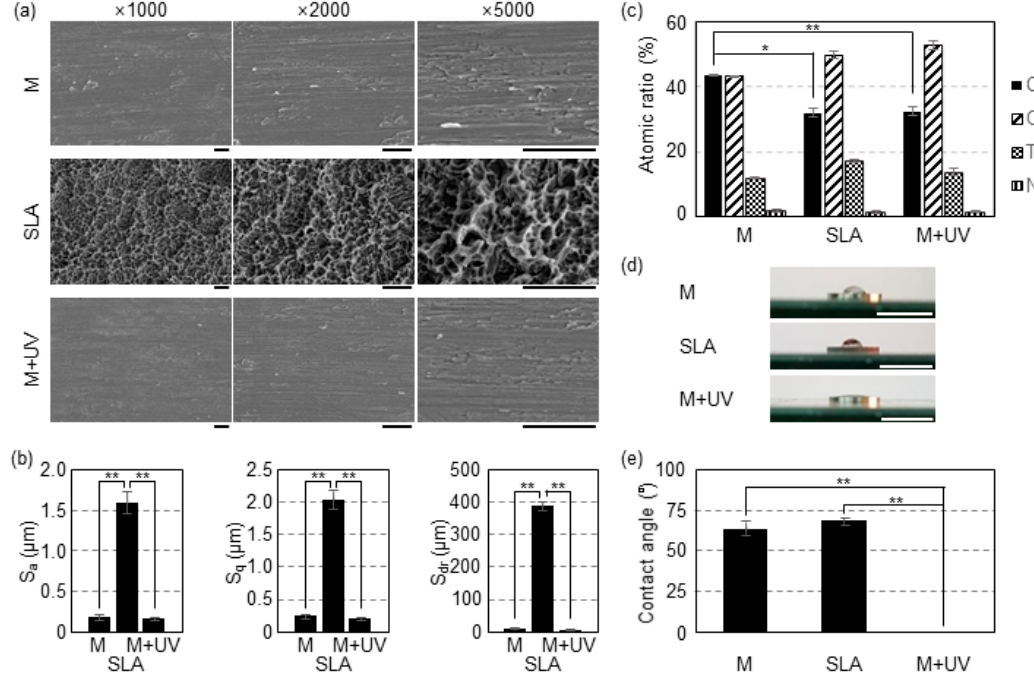
Figure 2. ( a ) Scanning electron microscopy (SEM) images of the Ti discs. M: Machined surface (top row); SLA: Sandblasted with large grit and acid etched surface (middle row); M + UV: machined surface treated with ultraviolet light (bottom row). Scale bars: 10 μ m. ( b ) Surface roughness (Sa and Sq) and surface area ratio (Sdr) of the Ti discs evaluated by confocal laser scanning microscopy (CLSM) analysis. The values for the M and M + UV surfaces are similar and smaller than the SLA. ( c ) Element content of the surfaces of the Ti disc according to the energy dispersive x-ray spectrometer (XPS). M + UV shows a significantly lower carbon percentage than the M disc, but there is no significant difference between the SLA and M + UV. ( d ) The changes in wettability of the Ti discs. Superhydrophilicity after UV treatment for 48 h was observed. Scale bars: 10 mm. ( e ) The value of the contact angle of the Ti discs. Without UV treatment, the Ti disc was hydrophobic, but became superhydrophilic (zero degree angle) after UV treatment for 48 h. Error bars show the standard deviation. (*) and (**) represents significance compared with each pair, p < 0.05 and p < 0.01, respectively.